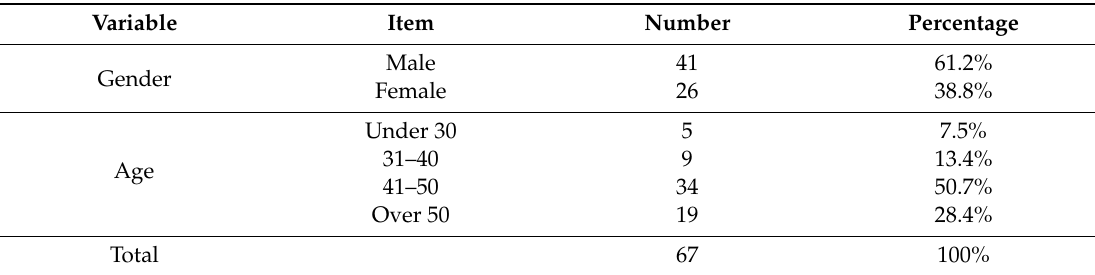
Table 6. Overall demographic